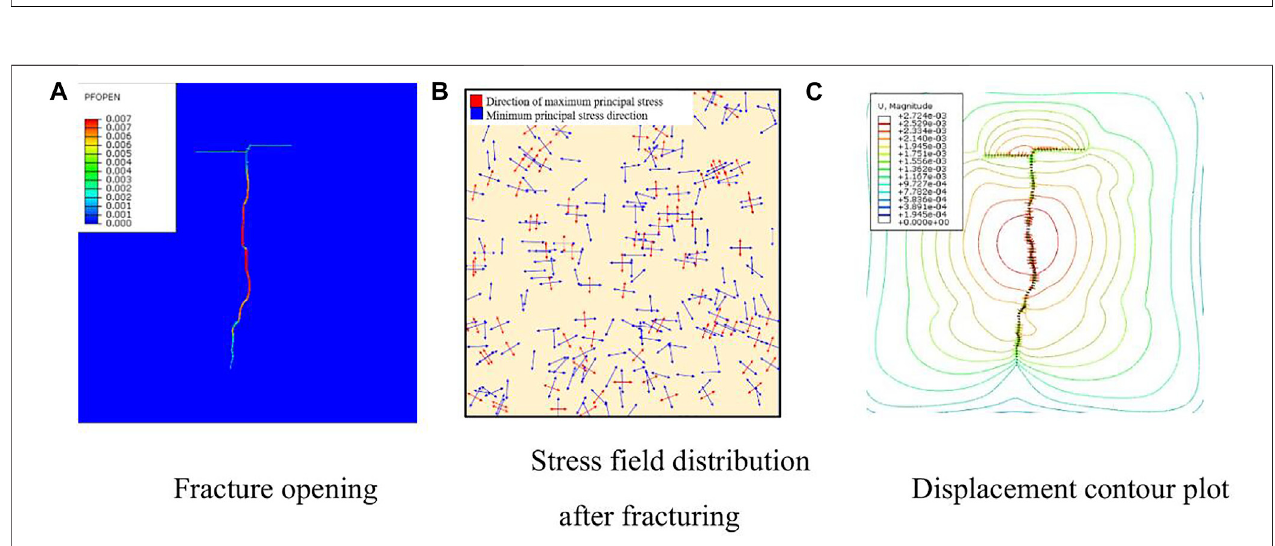
FIGURE 6 | The results of simulation. (A) Fracture opening. (B) Stress fi eld distribution after fracturing. (C) Displacement contour plot.